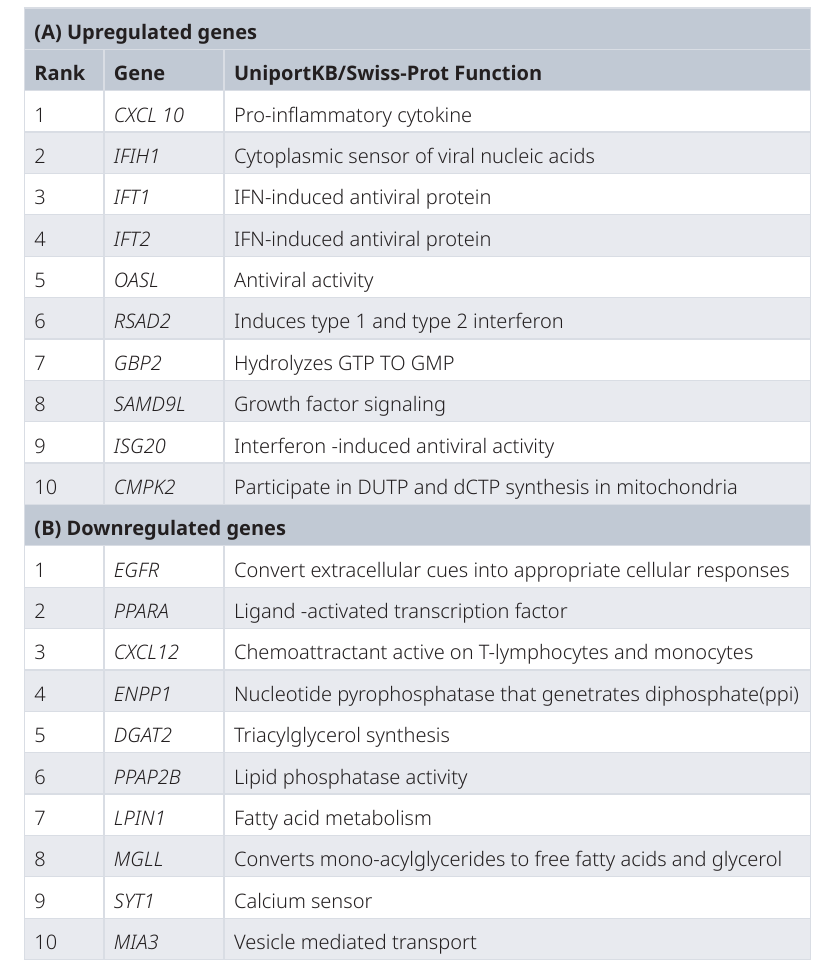
Table 1. Genes with the greatest changes in expression. We observed that the top ranked hub genes in PPI network which were upregulated were associated with immune activity while those downregulated are associated with cell signaling and fatty acid metabolism. EGFR came first in the ranking which is a critical receptor in several cell signaling